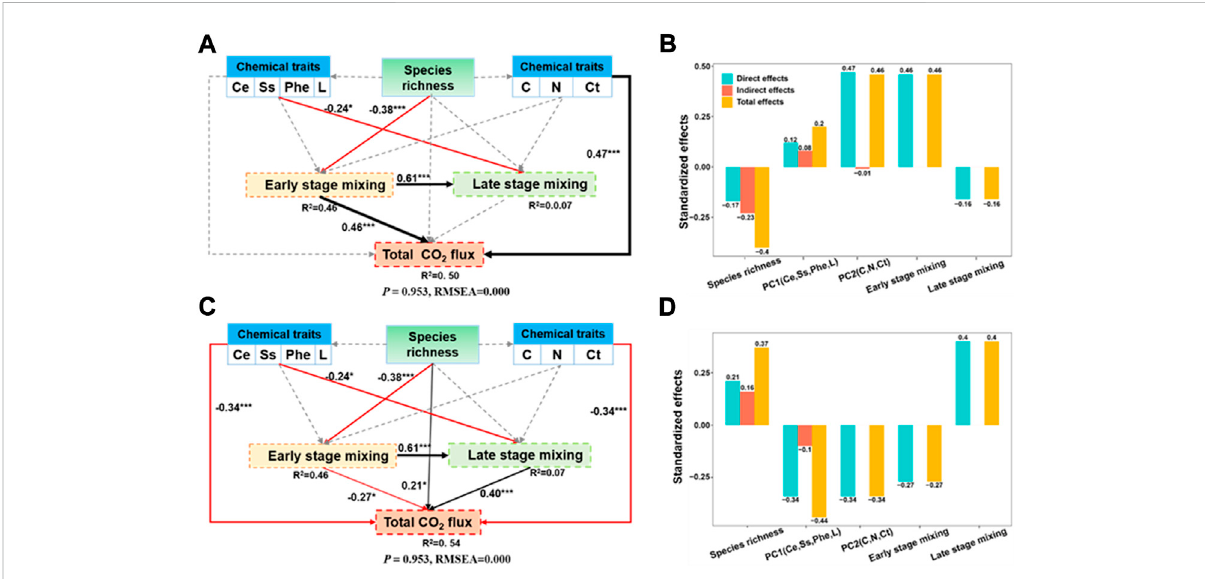
FIGURE 6 Structural equation model (SEM) evaluating the direct and indirect effects of litter species richness and litter quality index on early-stage CO 2 fl ux (A) , late-stage CO fl ux (C) , the standardized effects of these factors derived from the SEM (B,D) . Red and black lines indicate negative and 2 positive relationships, respectively; grey dotted lines indicate the relationship is not signi fi cant at p < 0.05 level; Number adjacent to arrows are standardized path coef fi cients, indicating the effect size of the relationship. * denotes signi fi cant difference at p < 0.5, ** denotes signi fi cant difference at p < 0.05, *** denotes signi fi cant difference at p <